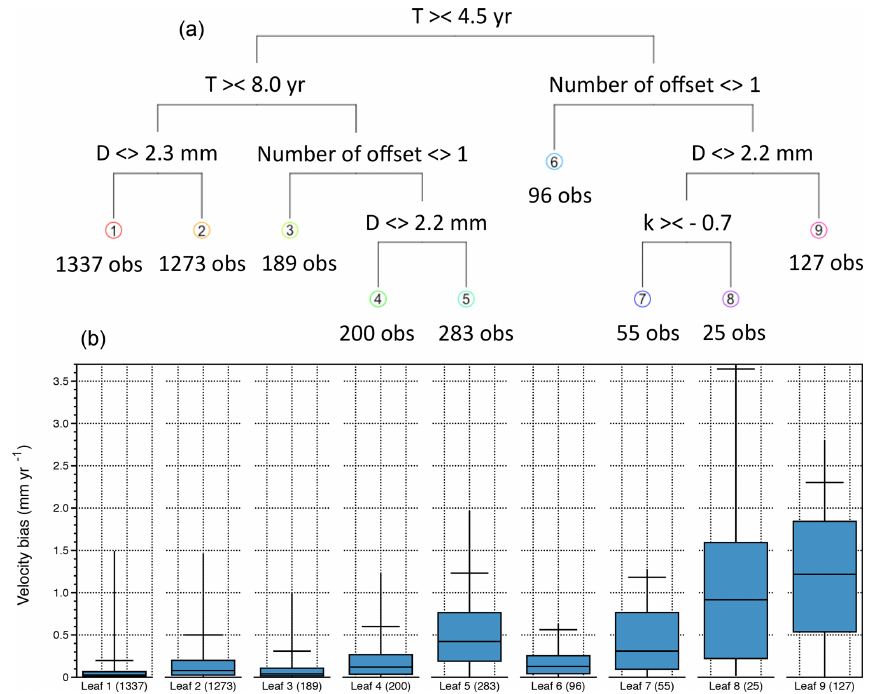
Figure 7. The regression tree classification (a) and the whisker plots of the associated leaves (b) for the full dataset with multiple offsets, variable noise, and seasonal signals with the application of the offset detection method. The horizontal top bar represents v 95